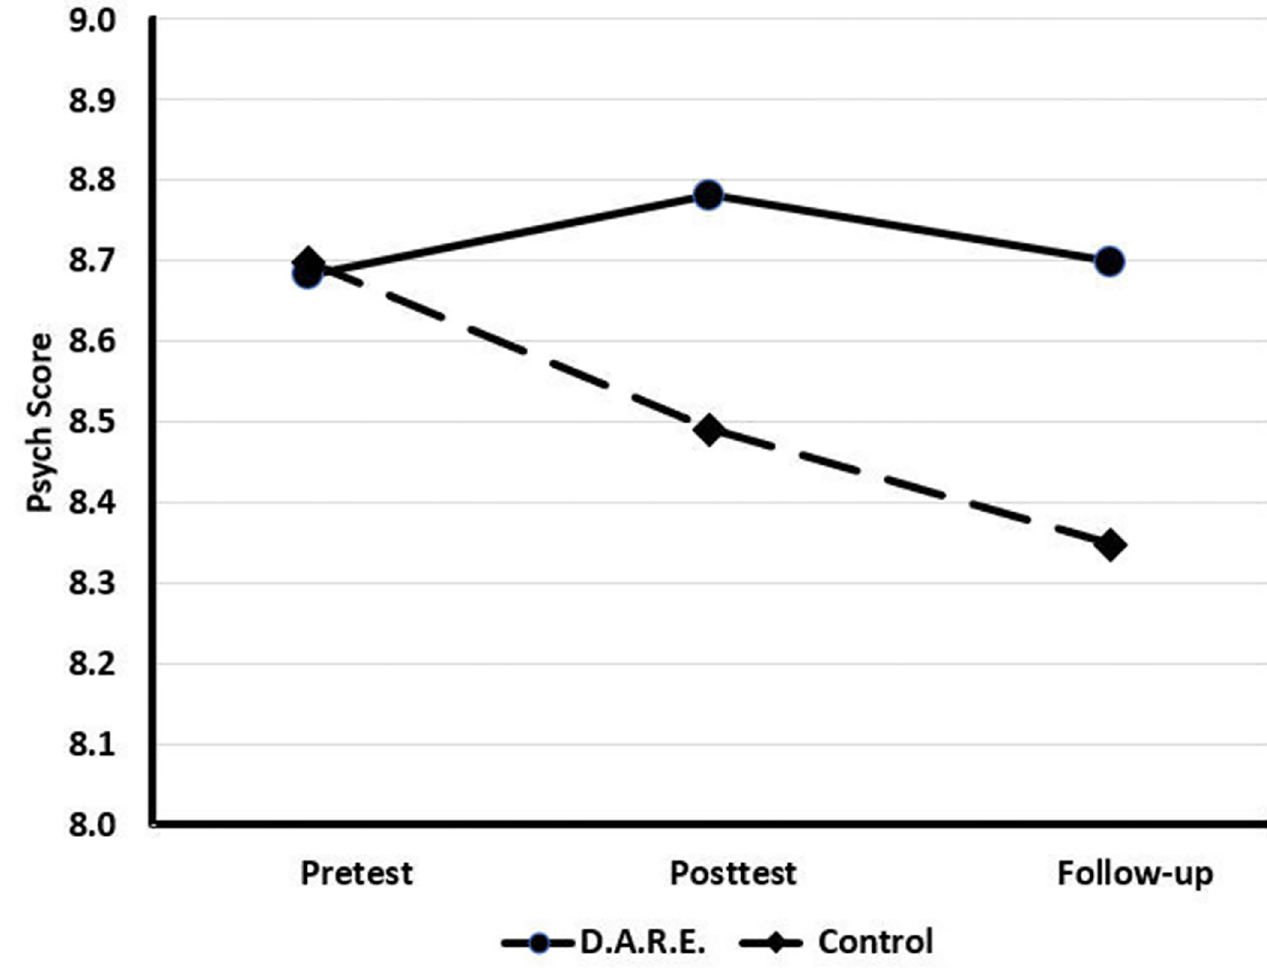
Fig 3. Comparison of psych scores for students receiving D.A.R.E. and virtual control cases.